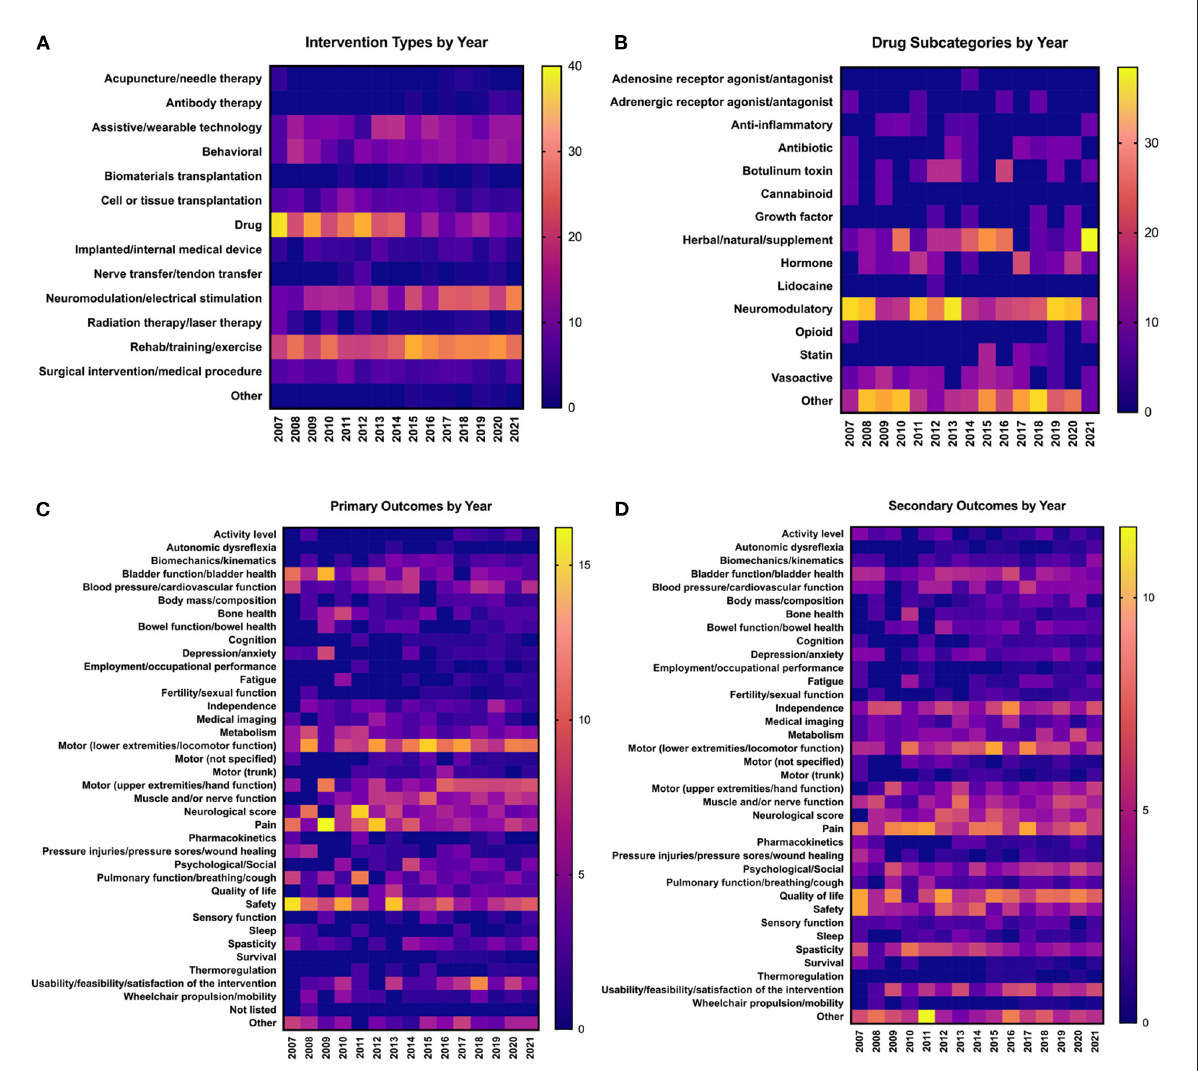
FIGURE4 Trends in clinical trial interventions and outcomes over time. Data are from clinical trials initiated between 2007 and 2021. All data are represented as percentages of the trials in a given year that utilize each type of (A,B) intervention or (C,D) outcome; values in individual columns add up to 100%. (A) Frequency of types of interventions used in clinical trials each year. (B) Breakdown of the types of drugs that make up the “Drug” category in (A) . Values in individual columns add up to 100% of total drugs in a given year. (C) Frequency of types of primary outcome measures assessed each year. (D) Frequency of types of secondary outcome measures assessed each